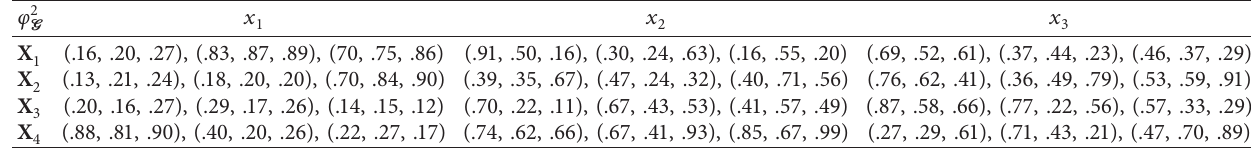
Table 6: G3-PNSS evaluation report according to experts of S